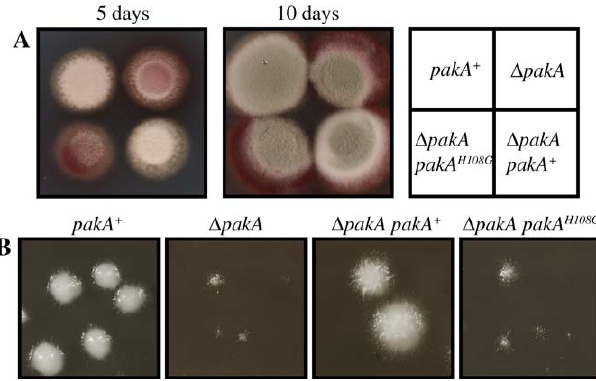
Figure 2. Vegetative Growth Is Reduced in Mutant pakA Strains (A) Hyphal growth of the wild-type ( pakA þ ), D pakA , D pakA pakA H108G , and D pakA pakA þ strains after 5 and 10 d incubation at 25 8 C. The D pakA and D pakA pakA H108G strains show reduced growth as evidenced by the red colony appearance due to significantly reduced aerial hyphal growth after 5 d. After 10 d, all strains are conidiating. (B) Yeast colonies of the wild-type ( pakA þ ), D pakA , D pakA pakA H108G , and D pakA pakA þ strains after 5 d at 37 8 C. The D pakA and D pakA pakA H108G strains show reduced growth at 37 8